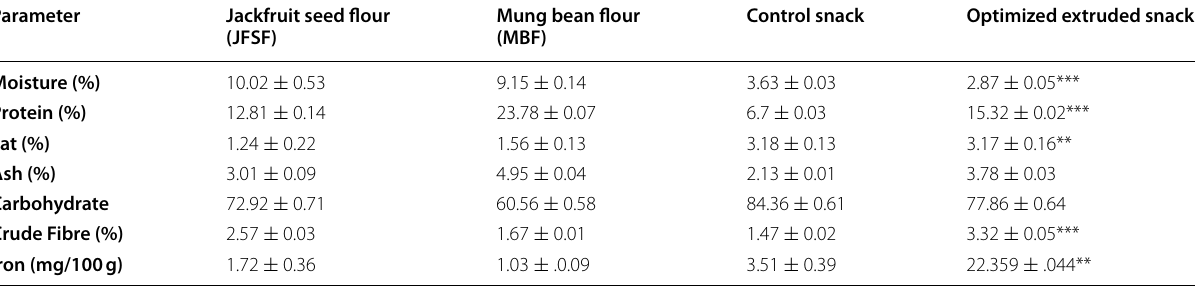
Table 5 Proximate composition (g/100 g) of jack fruit seed flour (JFSF), mung bean flour (MBF), optimized extruded snack and regular rich and corn